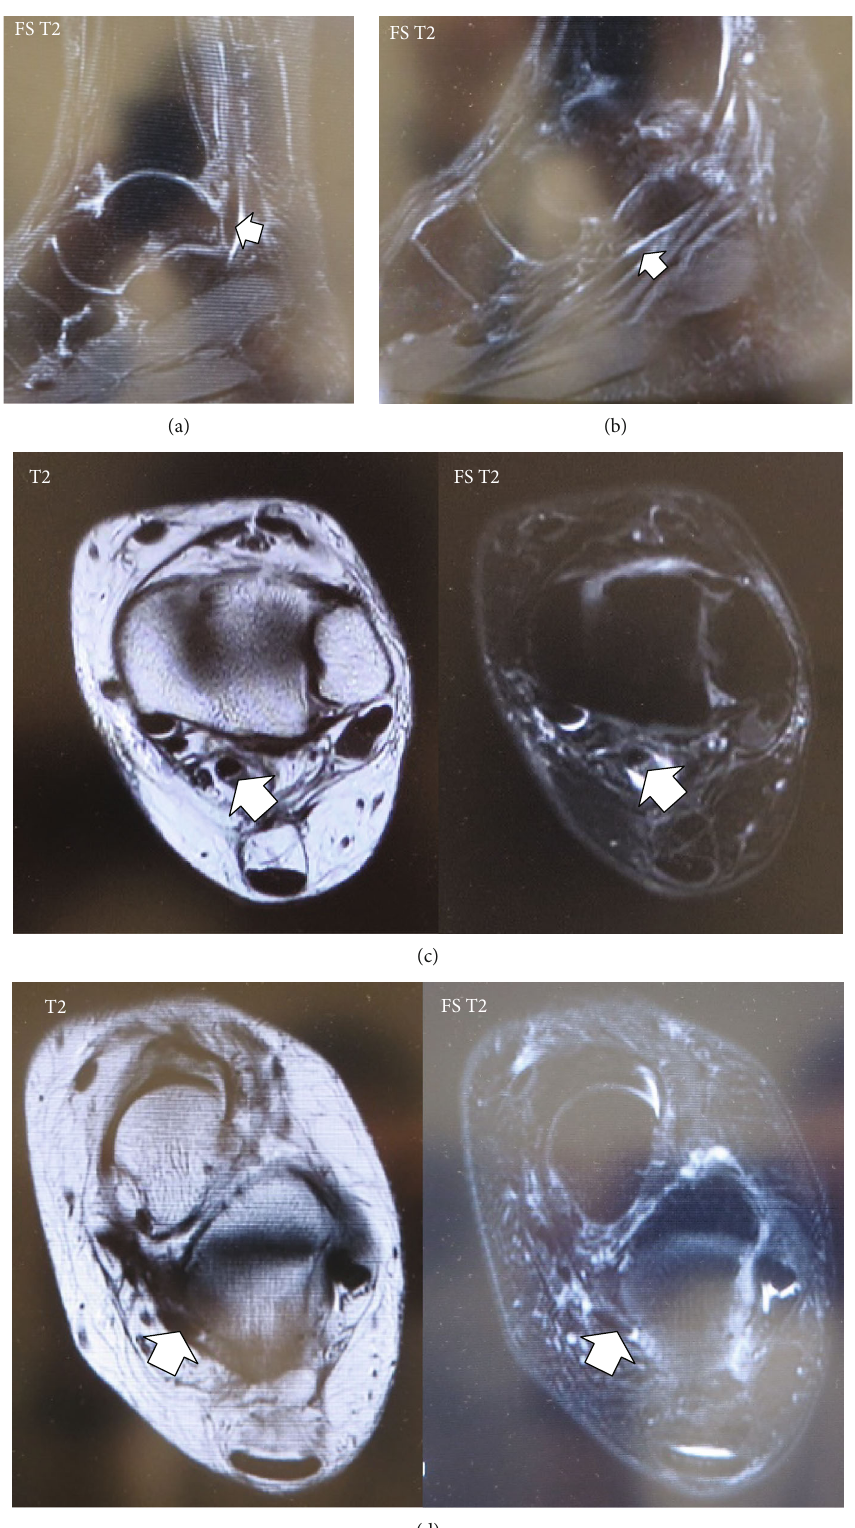
Figure 6: Fat saturation T2-weighted magnetic resonance images showing no e ff usion along the fl exor hallucis longus (FHL) tendon at a level proximal to the ankle joint posteriorly in the (a) sagittal and (b) axial planes. T2-weighted and fat saturation T2-weighted images showing no accumulation of e ff usion along the FHL between the talar tubercles and the master knot of Henry in the (c) sagittal and (d) axial